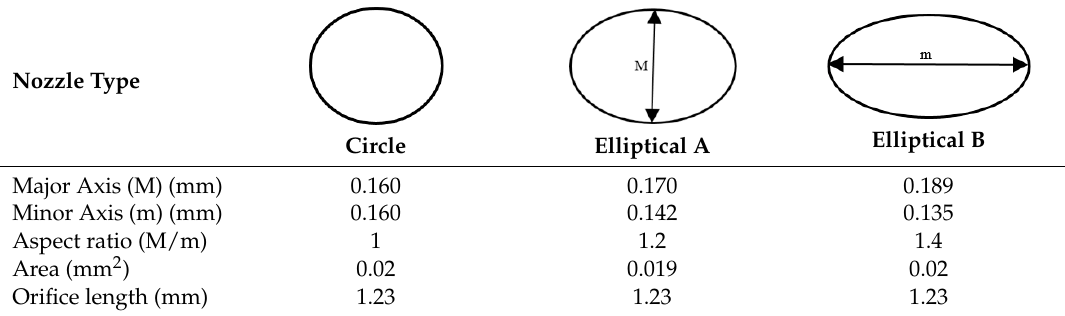
Figure 6. Injector geometry. Table 2. Injector hole geometric characteristics.